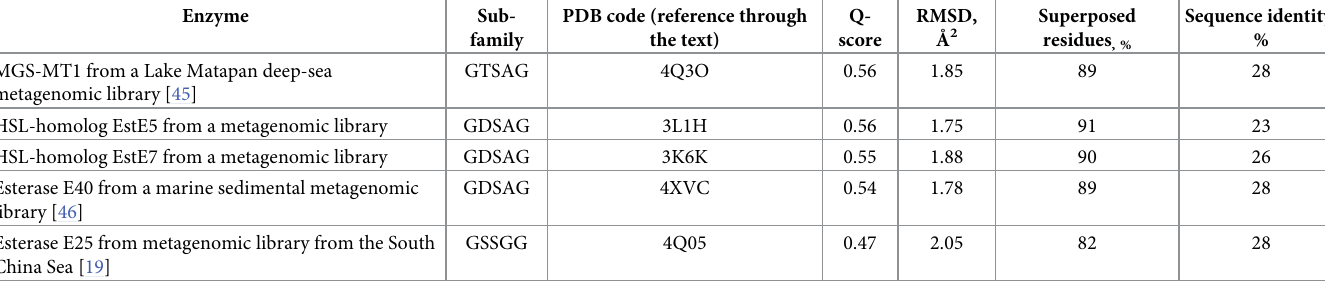
Table 2. Comparison of PMGL2 structure with the structures of homologous enzymes.